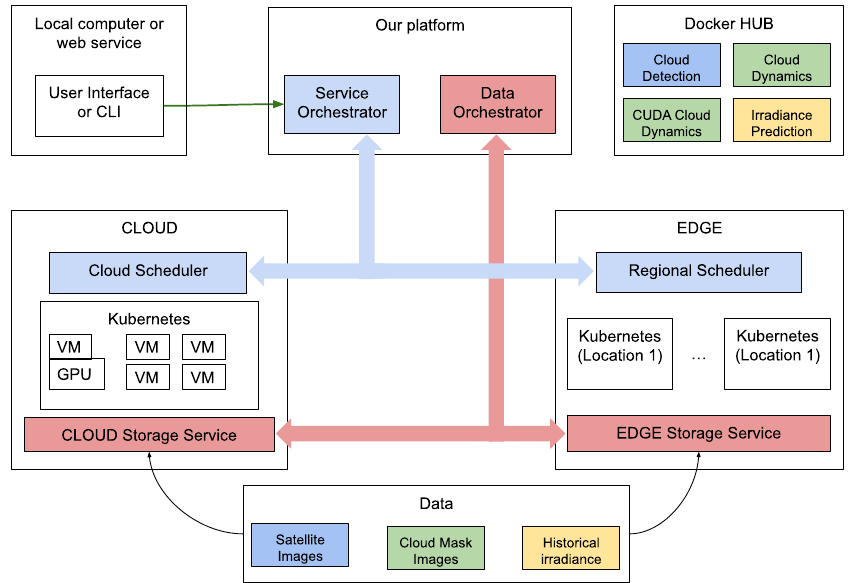
Figure 2. Detailed architecture of the proposed